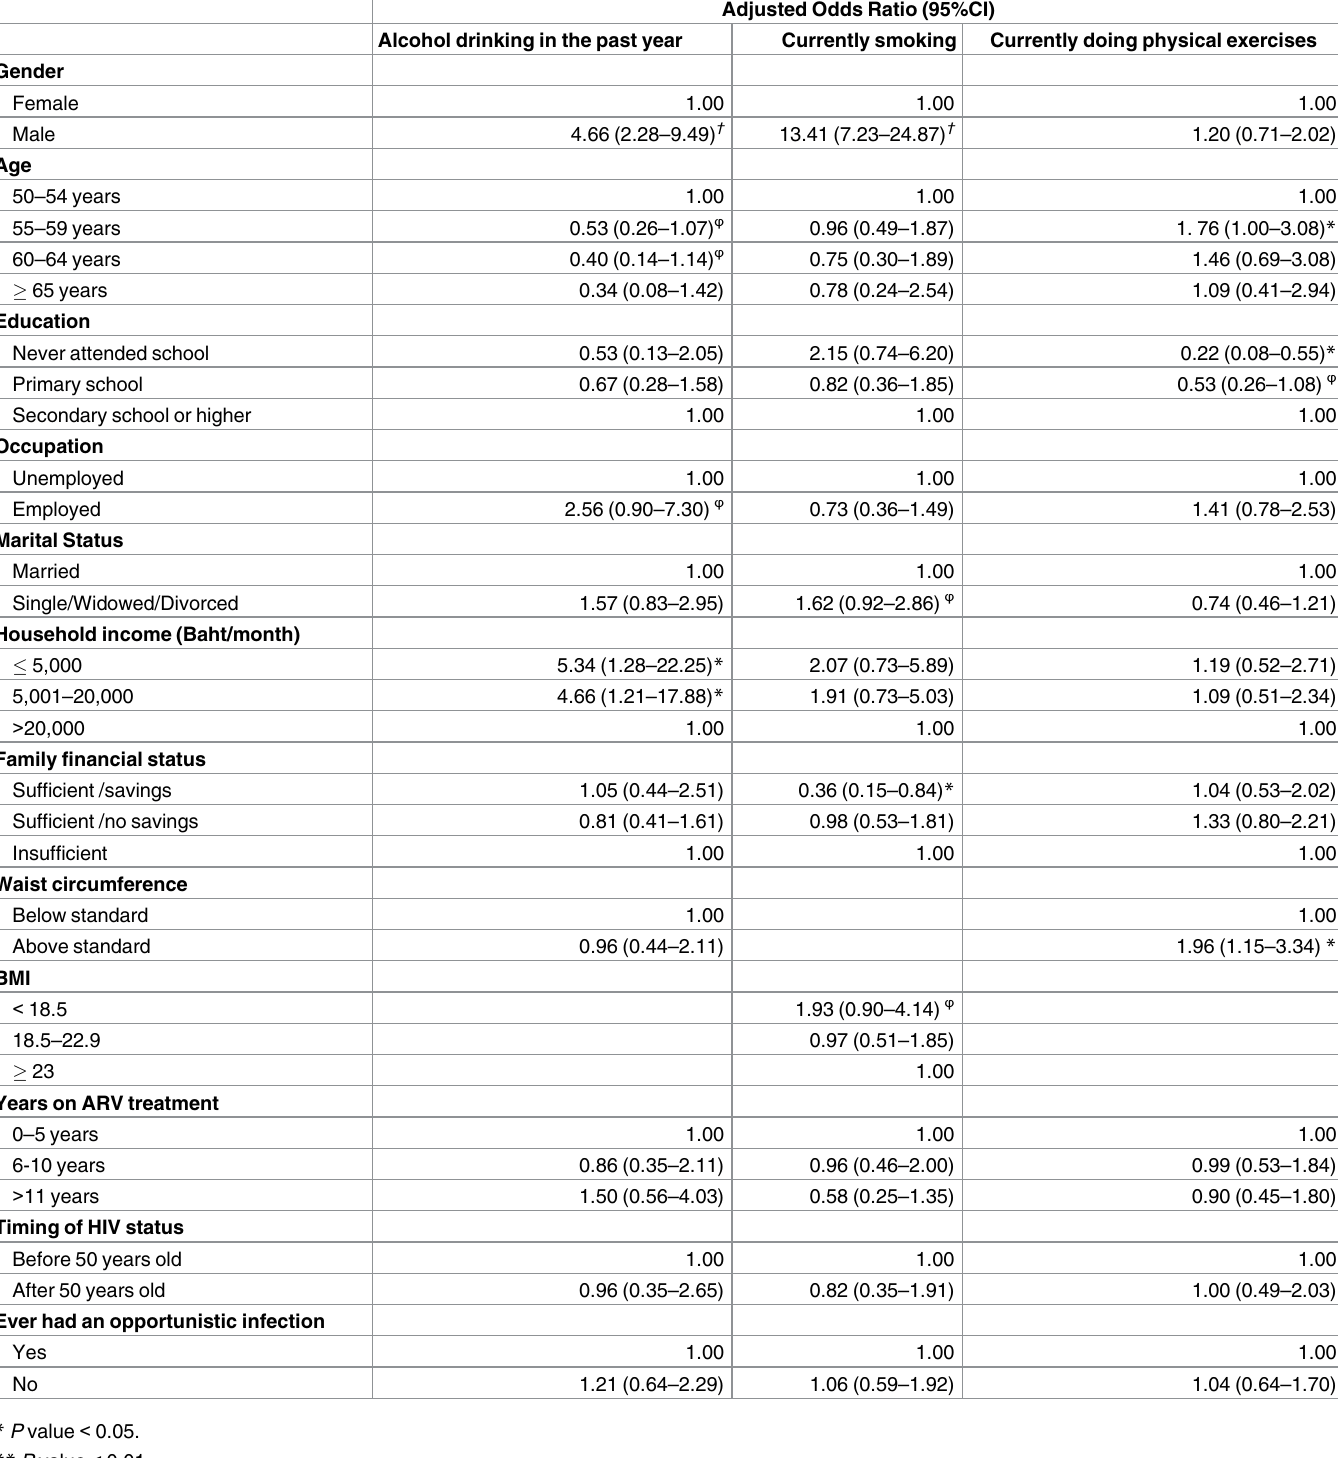
Table 3. Correlates of alcohol use, tobacco smoking, and physical exerciseamong OALHIV